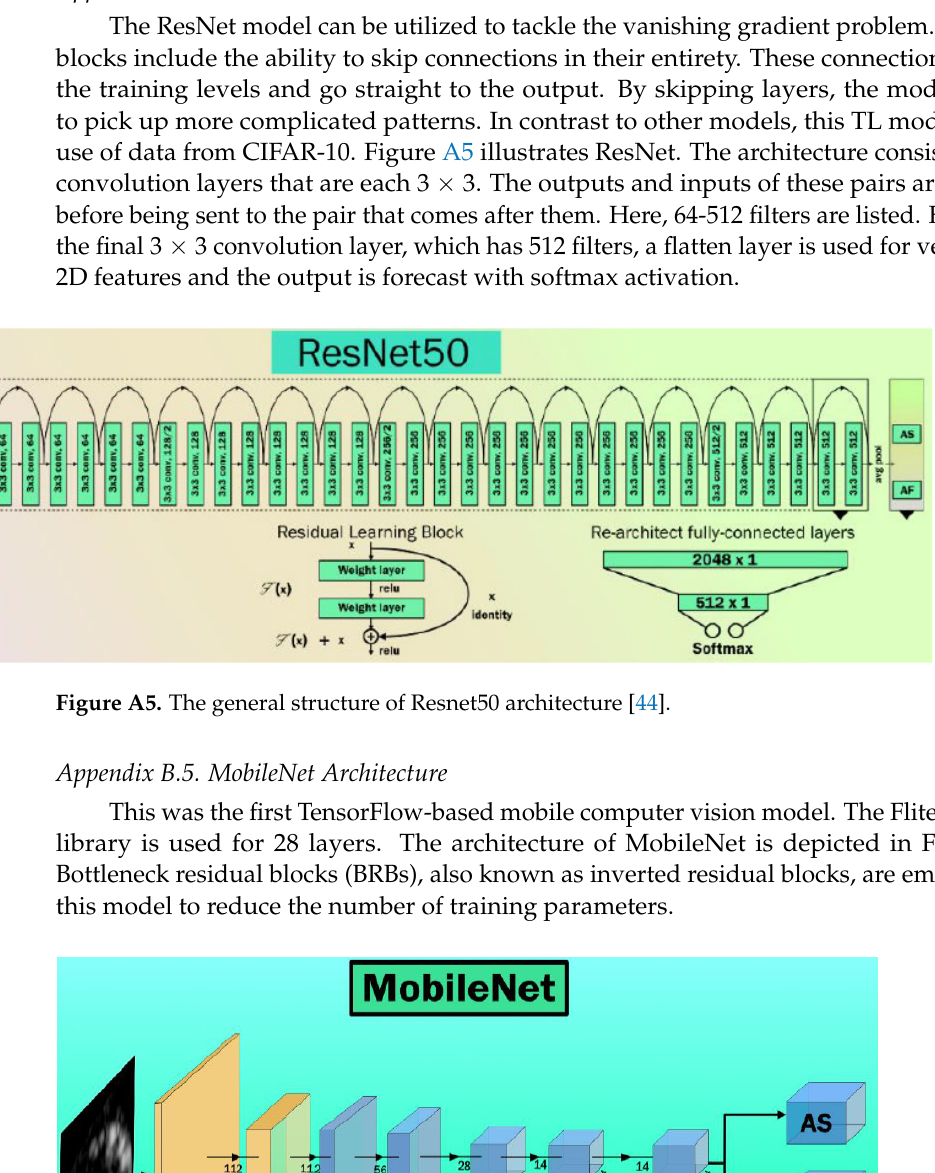
Figure A4. The general structure of XceptionNet architecture [44].